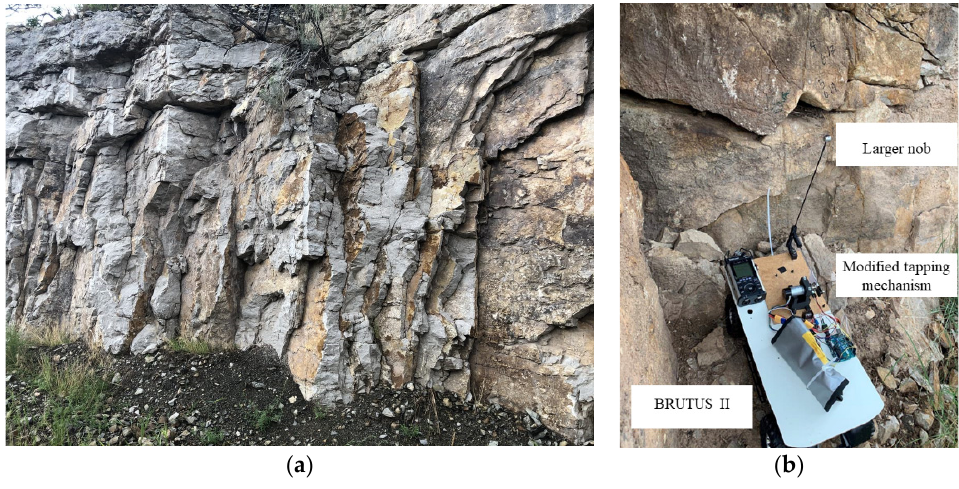
Figure 6. Field experiment: ( a ) Roadcut testing site; ( b ) modified UGV, BRUTUS II.